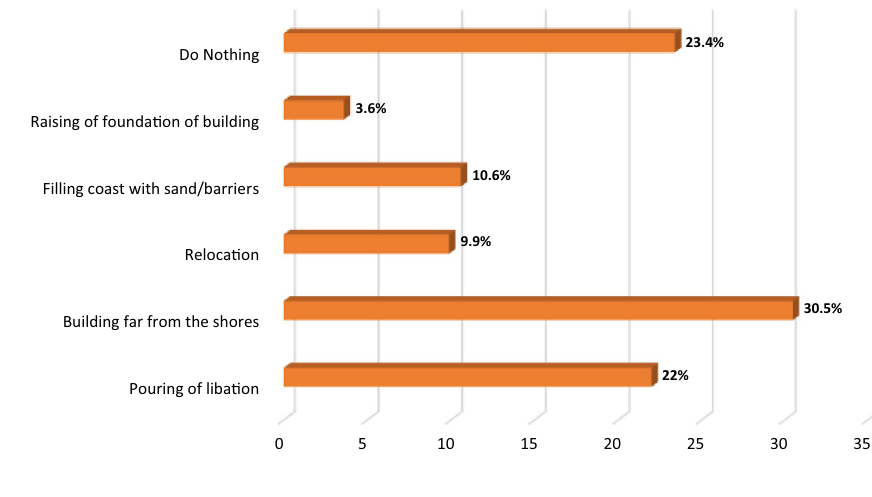
Fig. 4 Indigenous Strategies to Prevent Coastal